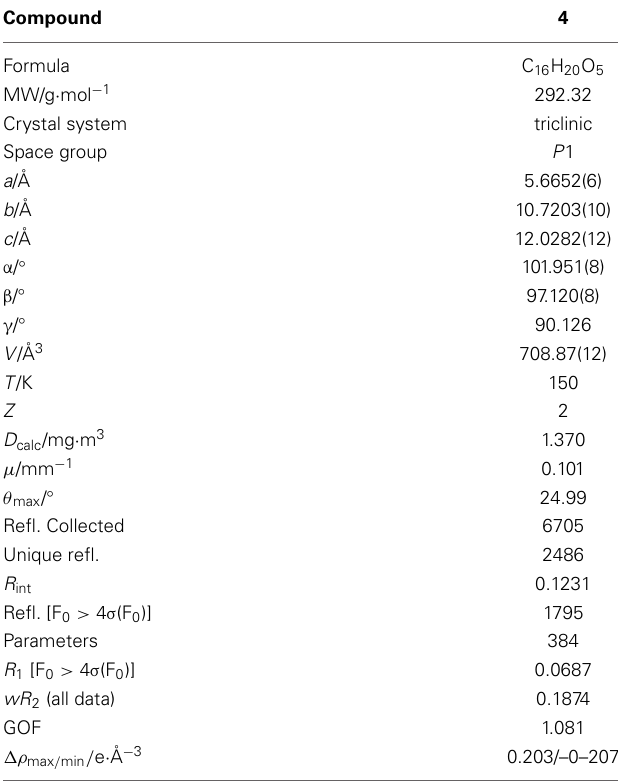
Table 1 | Selected crystal data and details of the structure refinement for 4.